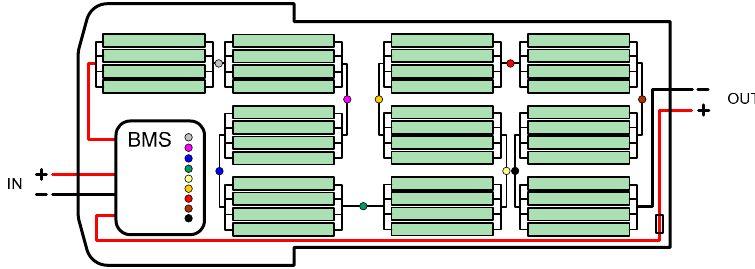
Figure 10. Principal structural diagram and electric schematic of 4p10s battery pack.